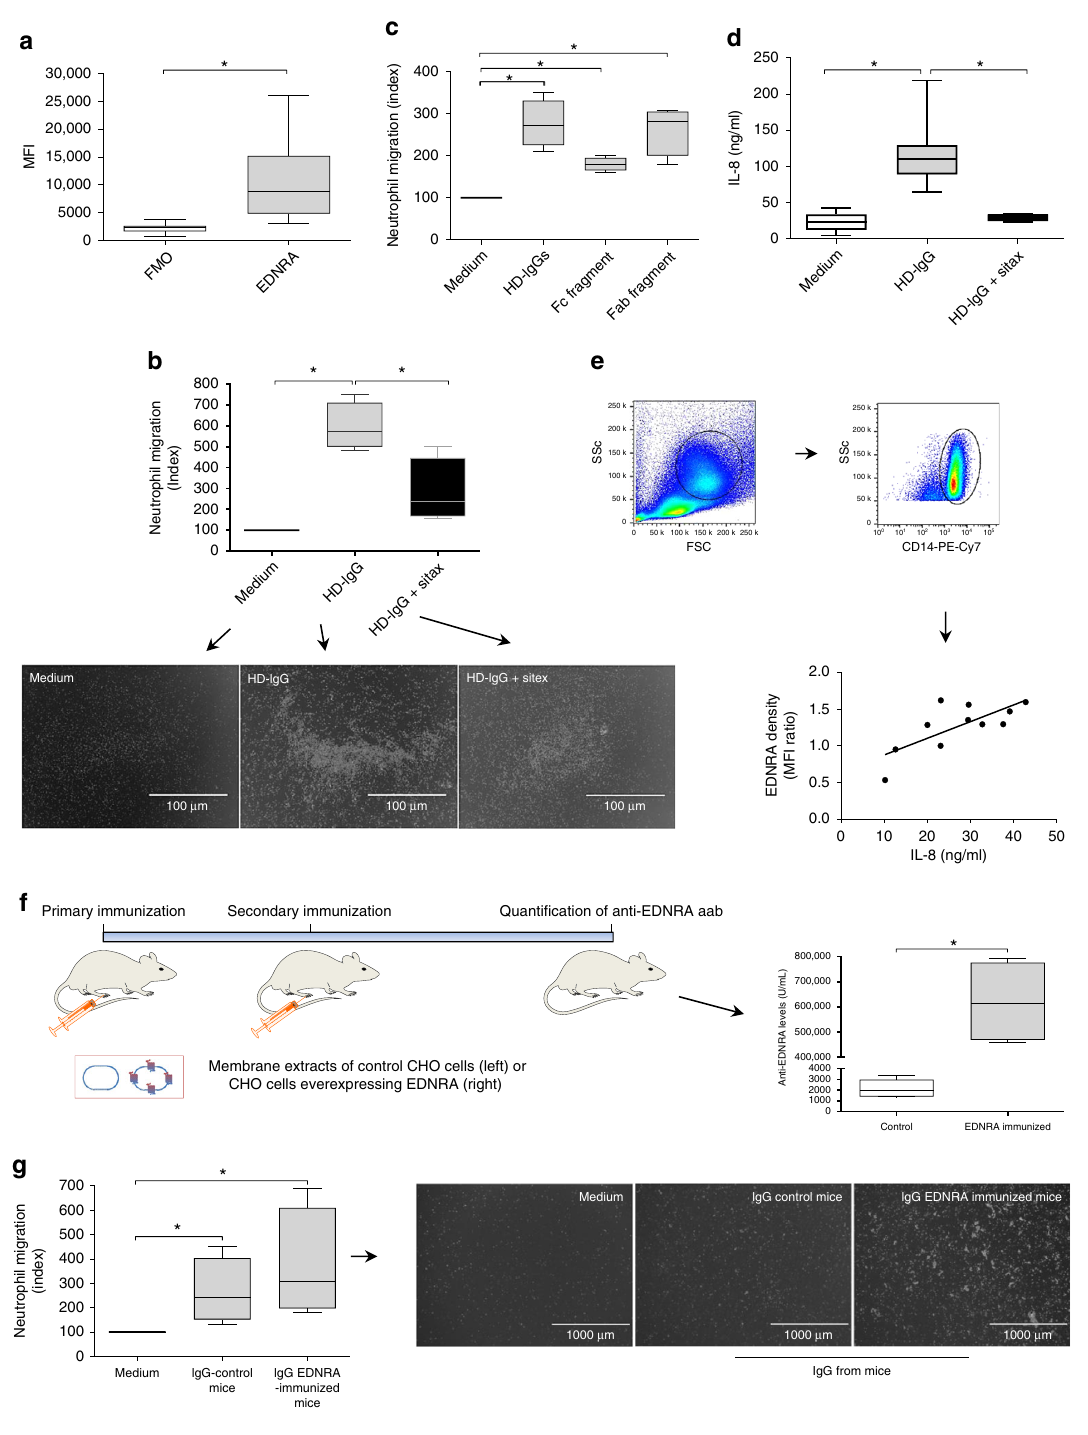
Migration assays . The capacity of antibodies to induce neutrophil chemotaxis was analyzed using the transwell migration assay (24-well plate, Corning Inc., Corning, NY, USA) as previously described 32 . For the analysis of HD-IgG-induced migra- tion, neutrophils were isolated from heparinized blood by dextran sedimentation followed by Ficoll-Hypaque centrifugation as previously described 30 . The purity, based on CD15 expression, was always above 97%, as was the viability before the migration assays. After Fc- γ receptor blockade with Human TruStain FcX Receptor Blocking Solution (Biolegend, San Diego, CA, USA), the isolated neutrophils (0.2 × 10 6 ) were transferred to the upper chamber, while RPMI containing total human IgG, Fc, and Fab fragments (Merck, Darmstadt, Germany) or IgG from EDNRA-